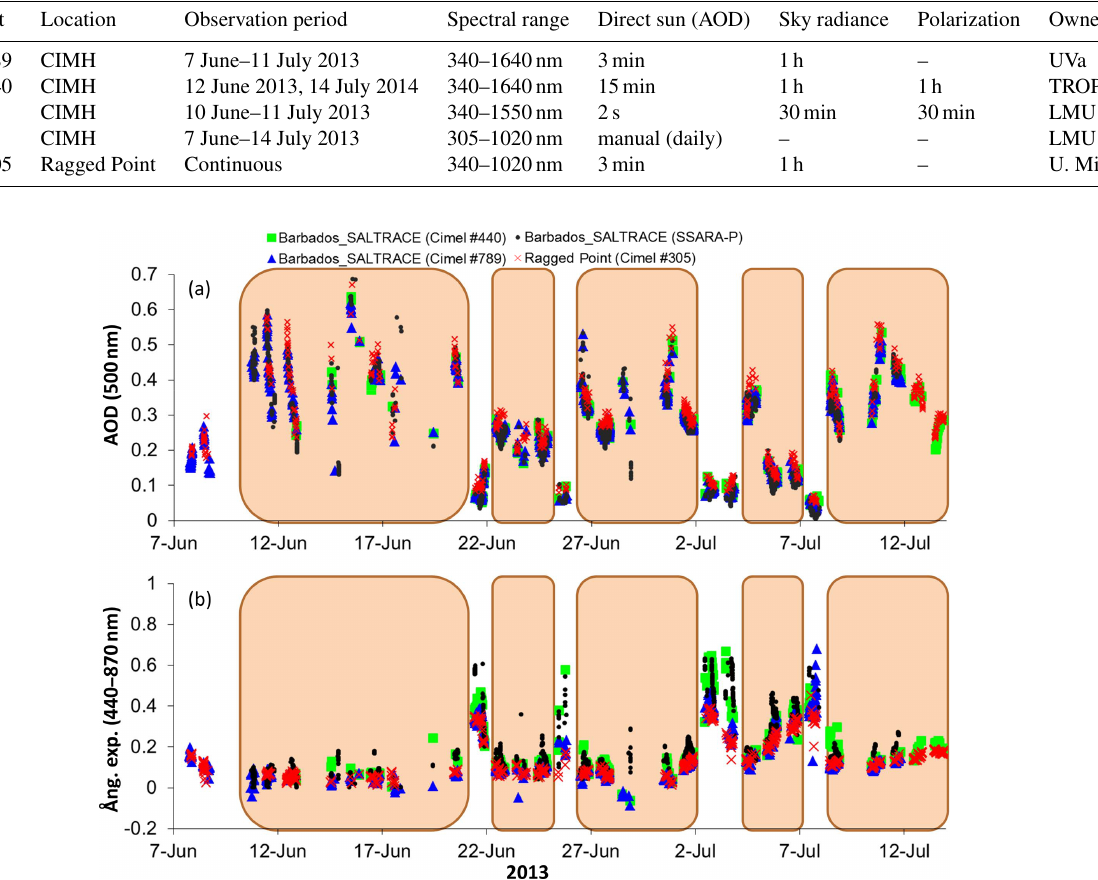
Figure 1. Aerosol optical depth (a) and Ångström exponent (b) observations during the SALTRACE campaign with all available sun pho- tometers: Cimel #789, Cimel #440 and SSARA-P at the CIMH site and Cimel #389 at the Ragged Point site. See the text and Table 1 for